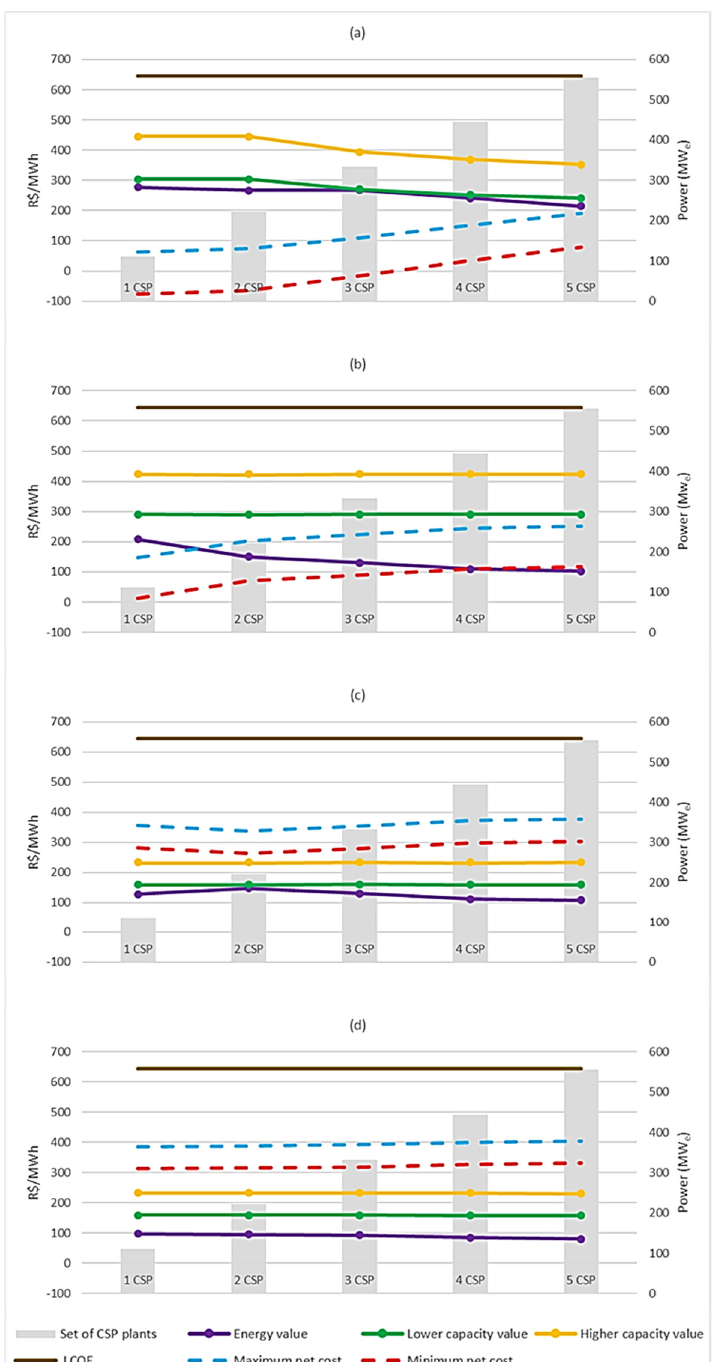
Figure 11. Economic benefits and the net cost of sets of CSP plants in the hydrothermal system in the following scenarios: wet/night ( a ), wet/day ( b ), dry/night ( c ), and dry/day ( d ). CSP plant 1 was also simulated to supply energy and power reserve to the